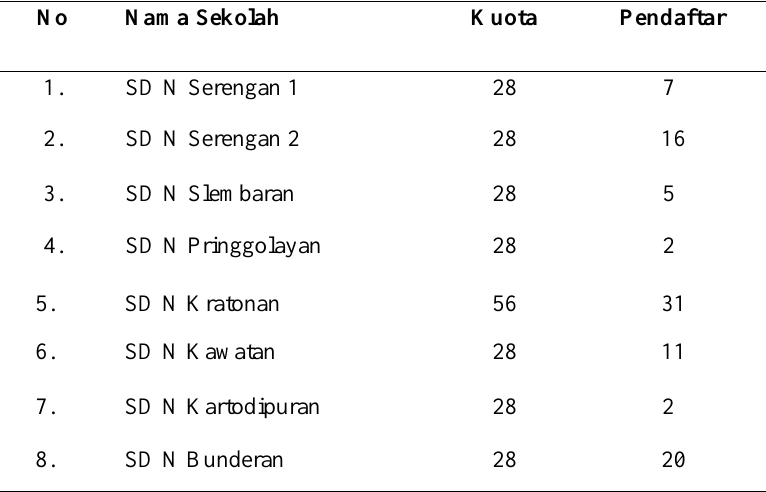
Tabel 2. Daftar Kuota Asli Zona Sekolah